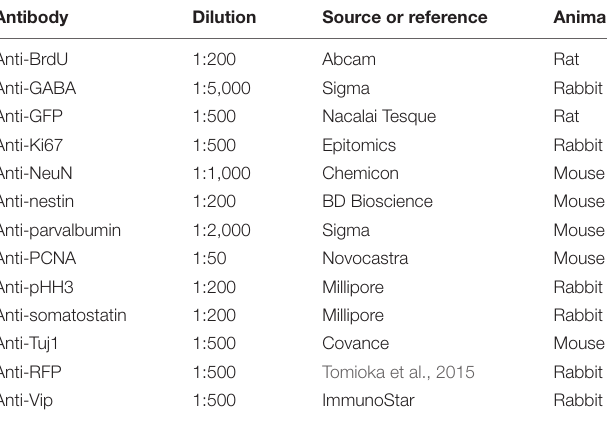
TABLE 1 | Primary antibodies used in this